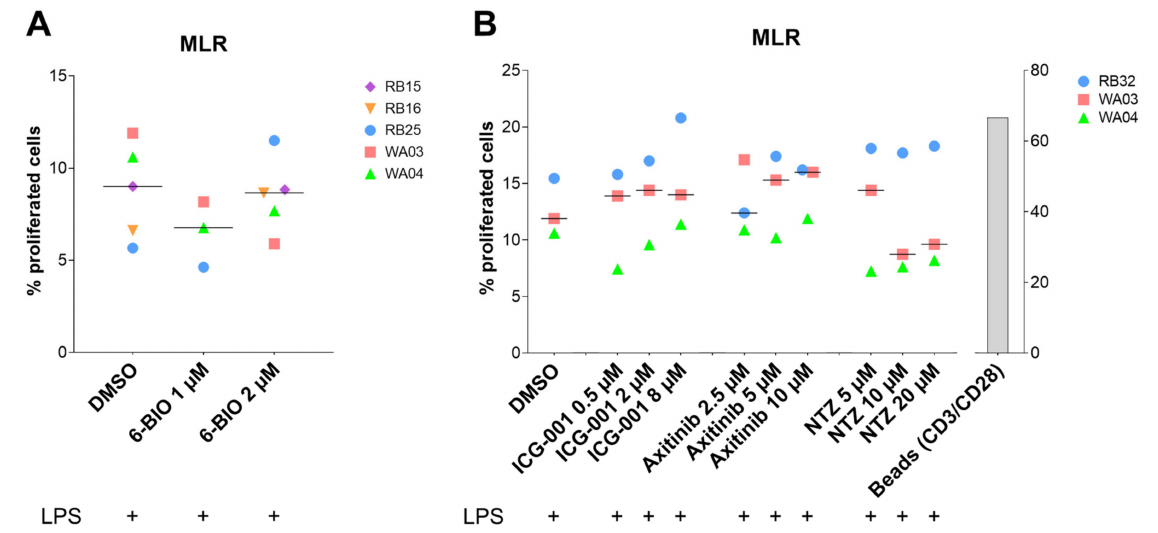
Figure 5. Mixed leukocyte reaction (MLR) performed between moDCs and monocyte-depleted PBMCs from another healthy donor. The moDCs were treated for 24 h with either indicated concentrations of 6-BIO or β -catenin inhibitors (type and concentrations as shown) and with concomitant LPS during the last 23 h. DMSO (vehicle) is the mature moDCs control. Allogeneic PBMCs were prelabeled with CFSE and cocultured with treated moDCs for 5 days. ( A , B ) Percentage of proliferated cells were measured by reduction in CFSE intensity. Each symbol indicates a different healthy donor, in 3 to 5 independent experiments. Donors were anonymized and each buffy coat labeled by initials of experimenter (RB or WA) and consecutive buffy coat number. Medians are indicated by